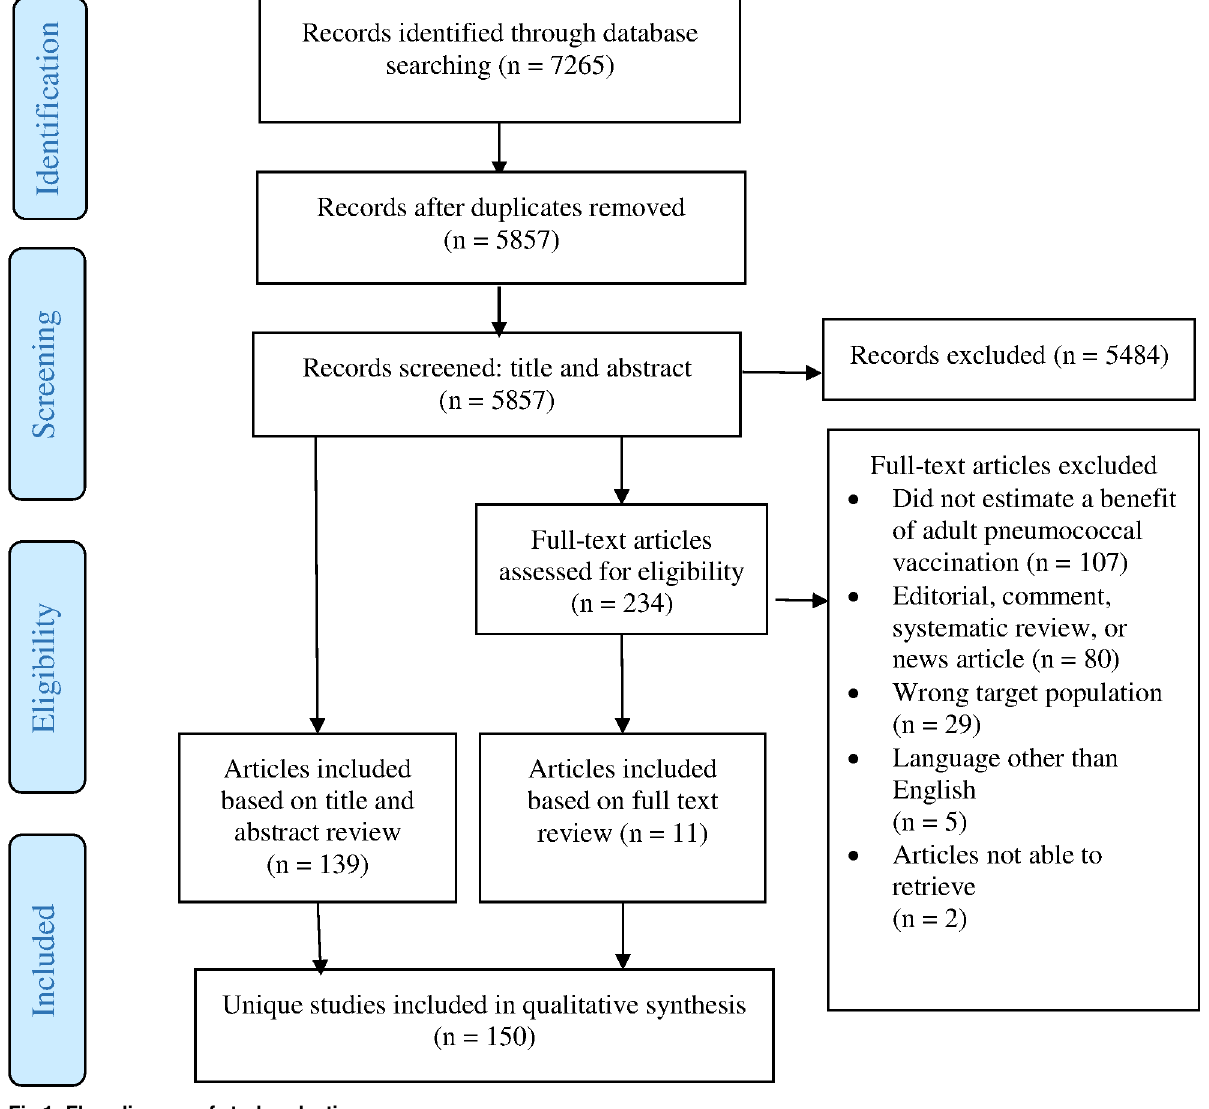
Fig 1. Flow diagram of study